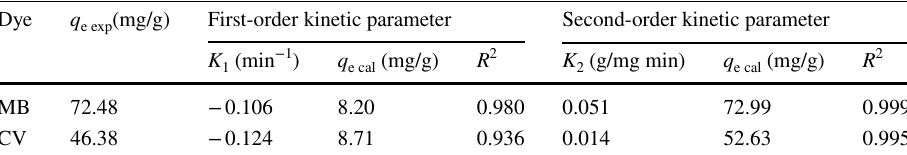
Fig. 8 a Effect of NaCl